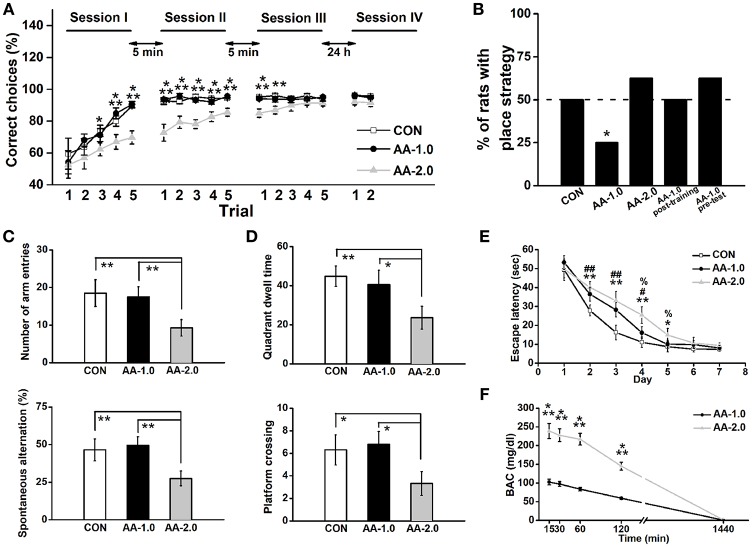
Low dose of AA induced response-strategy bias. Rats were i.p. injected with 1.0 g/kg (AA-1.0) or 2.0 g/kg (AA-2.0) alcohol 30 min before learning. (A) After 3 sessions of training, the performance of both control (CON) and low dose of AA (1.0 g/kg; AA-1.0) groups improved more rapidly than high dose of AA (2.0 g/kg; AA-2.0) group. During two trials of the session IV (probe session) was performed on the Second day, no difference among groups was found. (*P < 0.05, CON, or AA-1.0 vs. AA-2.0; **P < 0.01, CON, or AA-1.0 vs. AA-2.0; ***P < 0.001, CON, or AA-1.0 vs. AA-2.0). n = 8 for each group. (B) The percentage of animals that used a place strategy in last three trials of probe test, during which rats started from the opposite start arm (the start arm that was used during learning was blocked). Low dose group preferred to use a response strategy. (*P < 0.05 vs. only CON). n = 8 for each group. (C) In the Y-maze task, the number of arm entries (top) and percentage spontaneous alternation (bottom) were similar between low dose alcohol and control group. However, high dose of AA group made significantly low entries and percentage alternation. (**P < 0.01). n = 8 for each group. (D) After acquisition the location of platform, high but not low dose of alcohol induced low quadrant dwell time (top) and the number of platform crossing (bottom). (*P < 0.05; **P < 0.01). n = 8 for each group. (E) During the 7-day hidden-platform training, escape latency of both alcohol groups were prolonged but similar to control group in the last 2 training days. (*P < 0.05, CON vs. AA-2.0; **P < 0.01, CON vs. AA-2.0; #P < 0.05, CON vs. AA-1.0; ##P < 0.01, CON vs. AA-1.0; %P < 0.05, AA-1.0 vs. AA-2.0). n = 8 for each group. (F) BACs were detected following low or high dose of alcohol treatment. Both treatments enhanced BAC concentration, with a much higher level in AA-2.0 group. (***P < 0.001, AA-1.0 vs. AA-2.0). n = 5 for each group.